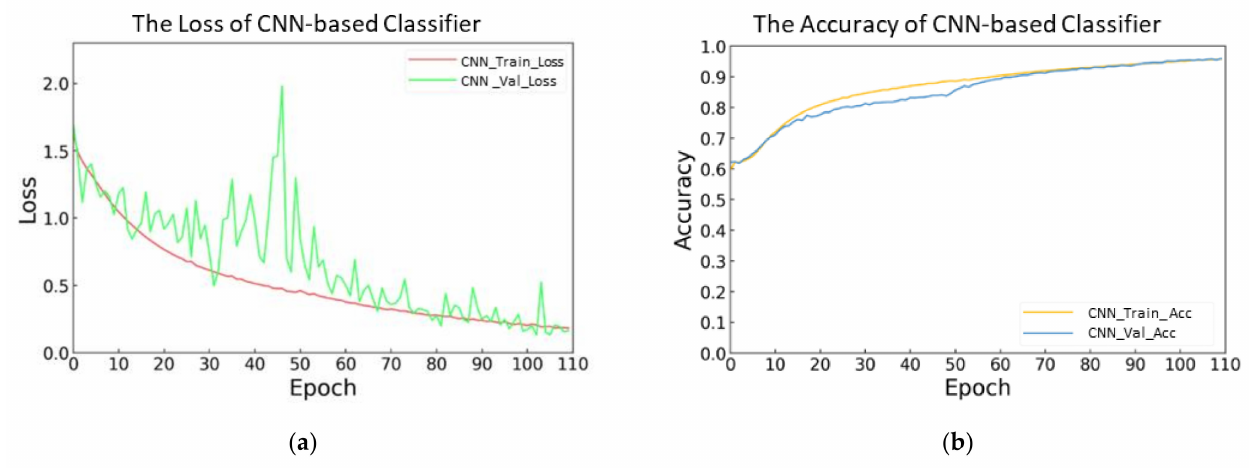
Figure 6. Convolutional neural networks (CNN): ( a ) The loss of CNN-based classifier. ( b ) The accuracy of CNN-based